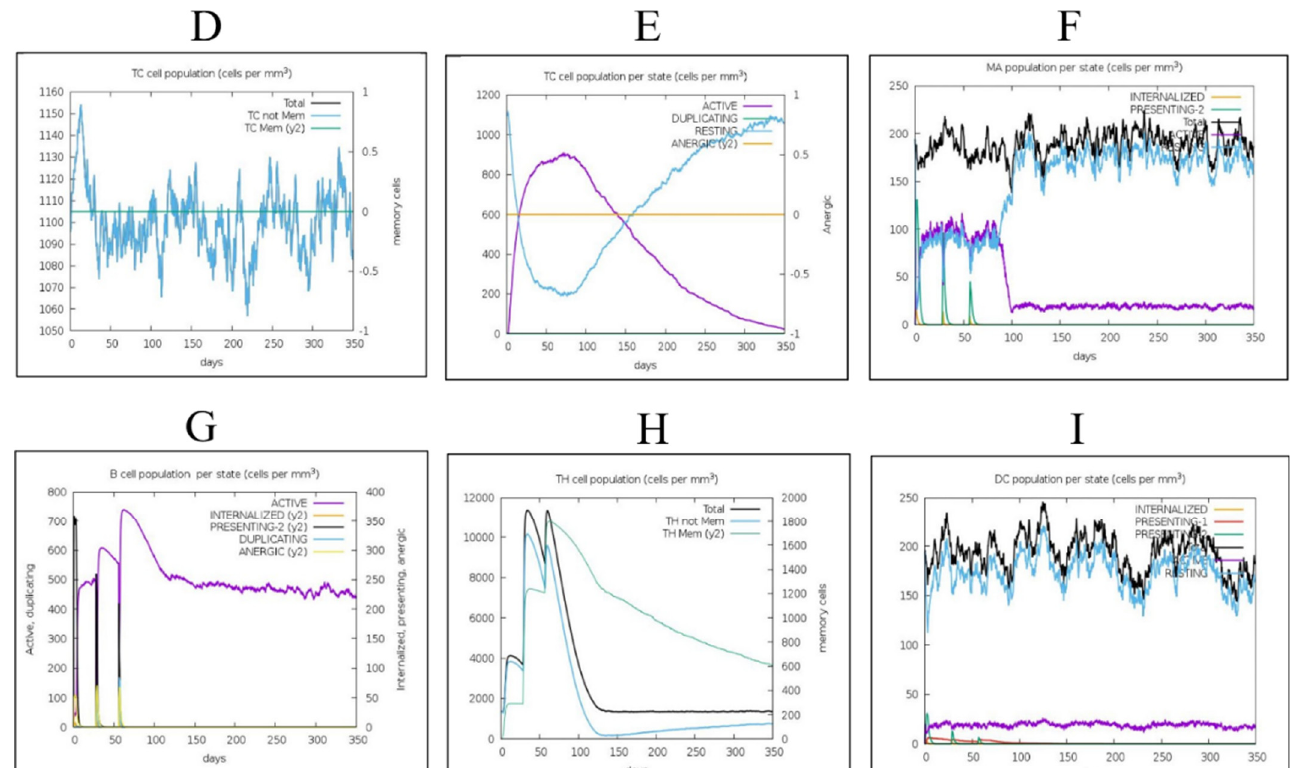
Figure 8. Simulations of the host immune response upon introduction of the vaccine designed. ( A ) B cell population after three injections, ( B ) immunoglobulin production in response to the injection of antigens to the host body, ( C ) Interleukin and cytokine levels, ( D ) Cytotoxic T cell population, ( E ) Cytotoxic T cell population per state, ( F ) Macrophage population per state, ( G ) B cell population per state, ( H ) Helper T cell population, and ( I ) Dendritic cell population per state.